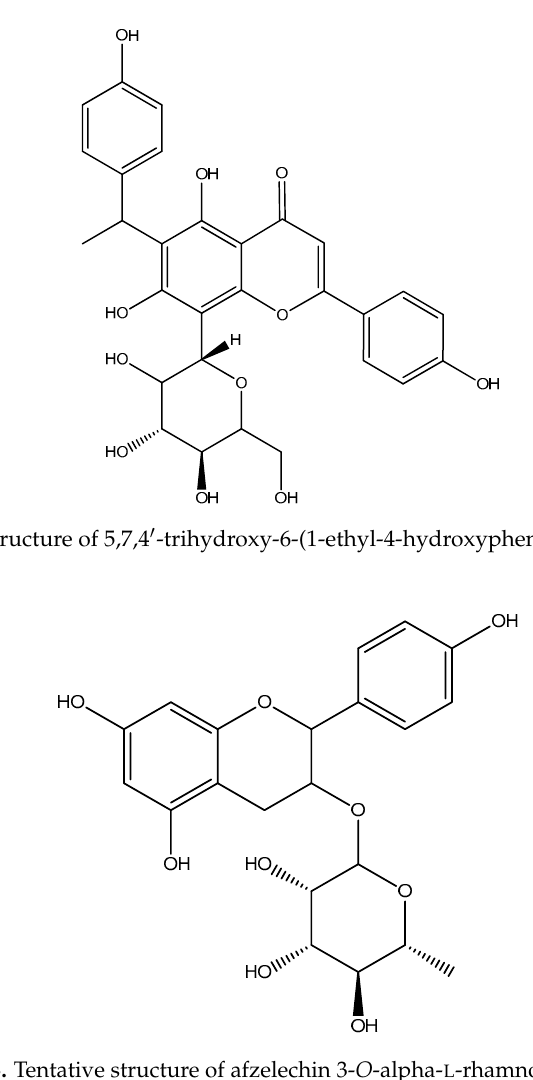
Figure 3. Tentative structure of afzelechin 3- O -alpha-L-rhamnopyranoside.